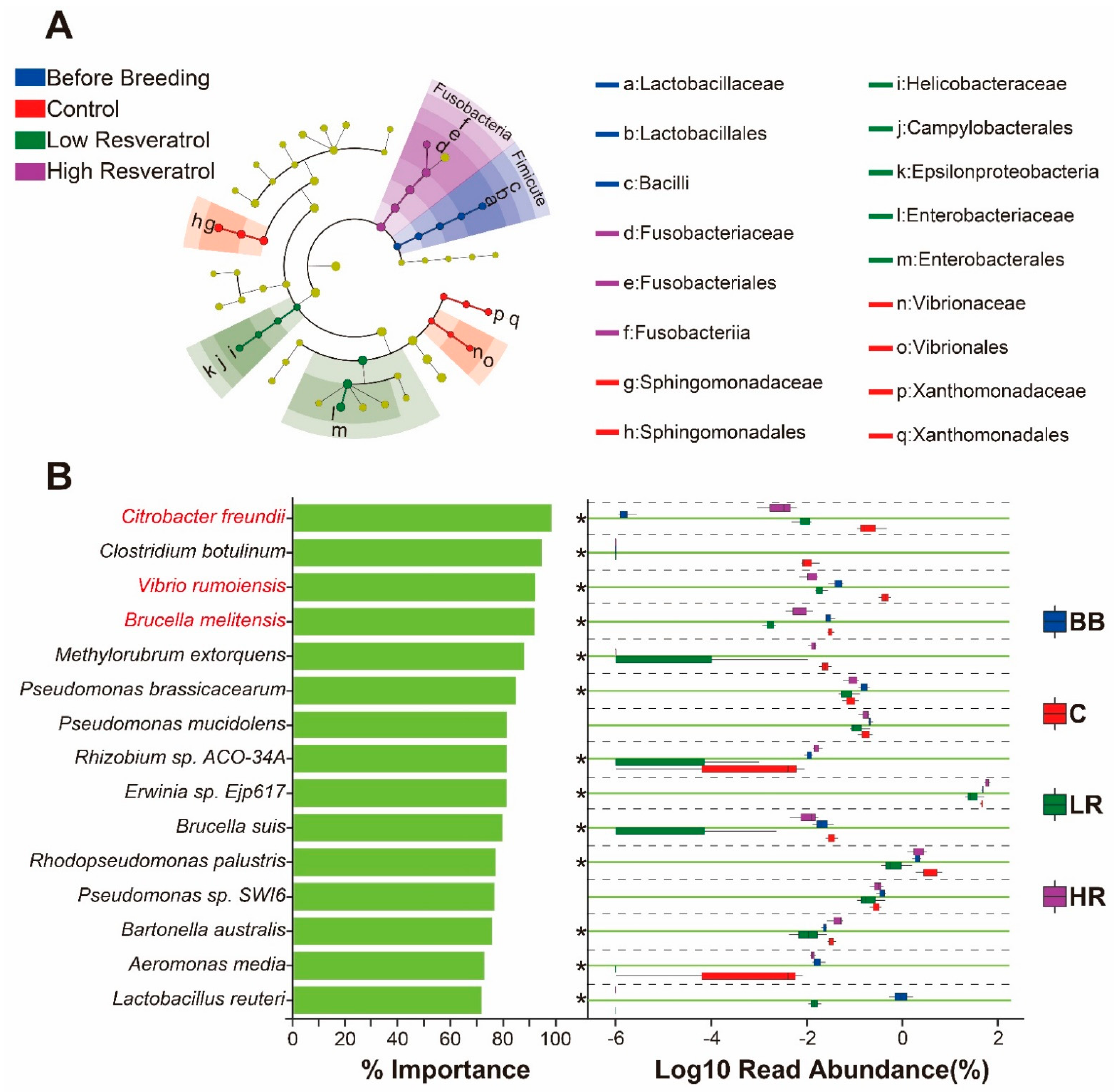
Figure 6. Identification of microbial markers for different groups by LEfSe analysis and random forest analysis for the samples from all groups in the duodenum. ( A ) Taxonomic cladogram generated from LEfSe analysis. Taxonomic characterization of differences in intestinal tissues among dif- ferent groups; concentric circles from outside to inside indicate different taxonomic classes (phylum to family), and different color areas point to different groups. The abundance of intestinal microbi- ota was revealed by the size of each node. ( B ) Variable importance plot from random forest classi- fier. Left graph shows top 15 bacteria with % importance (mean decrease in Gini) ≥ 70 among differ- ent groups, bacteria marked in red font indicate potential pathogenic bacteria. Right figure repre- sents abundance of corresponding communities by boxplots in different groups, with “*” on left side representing the difference significance of BB/LR/HR compared to C ( p < 0.05). 3. Discussion Resveratrol has been reported to function as a regulator for the intestinal microbial community and as a protector of the integrity of the intestinal barrier [24–26], protecting mainly through its anti-inflammatory modulation [27–29]. In aquatic animals [30],